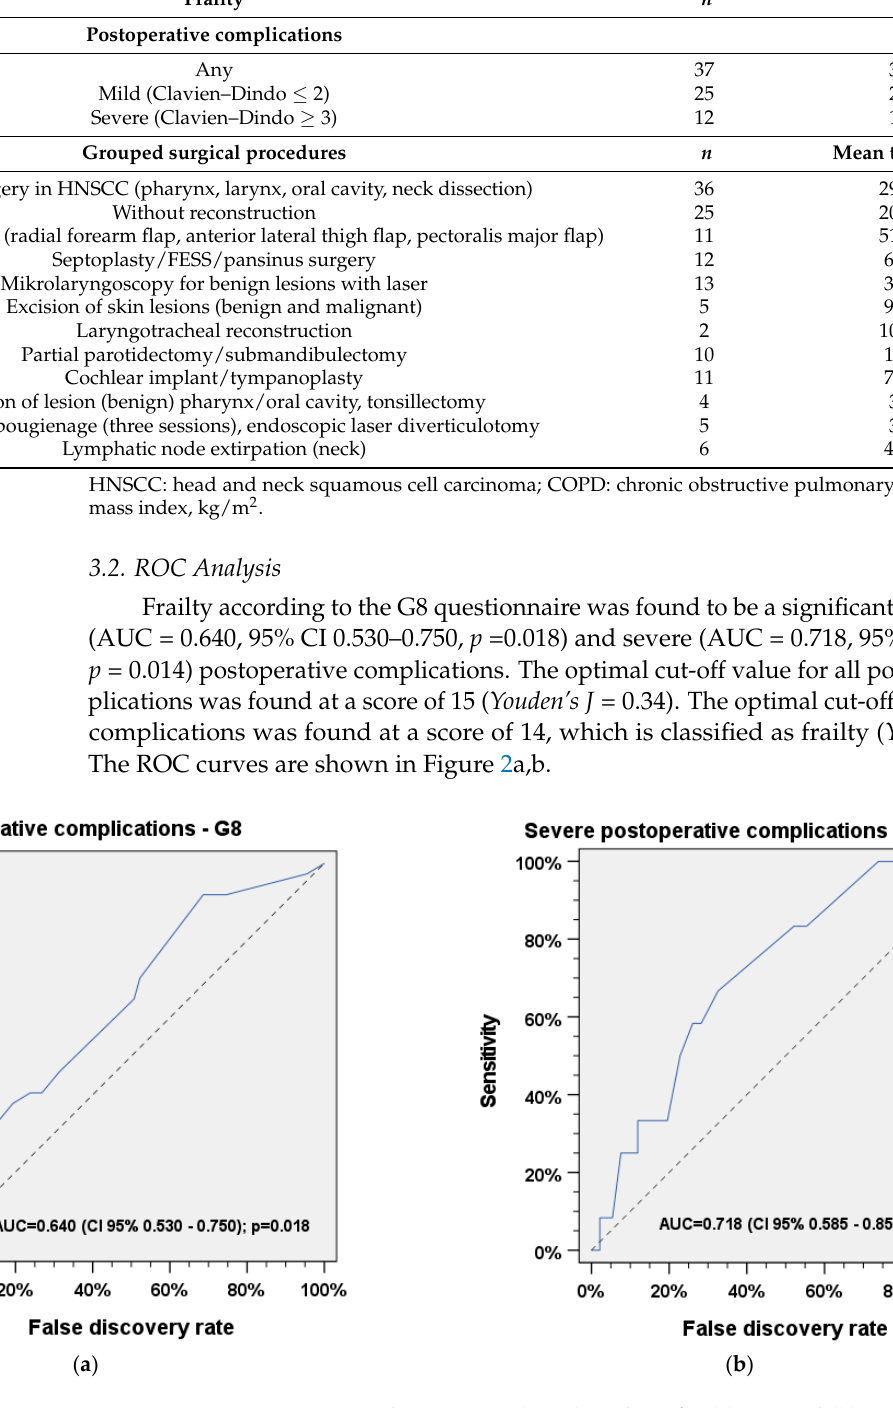
Figure 2. Receiver operating characteristic (ROC) analysis for ( a ) any and ( b ) severe postoperative complications vs. G8 questionnaire. complications vs. G8